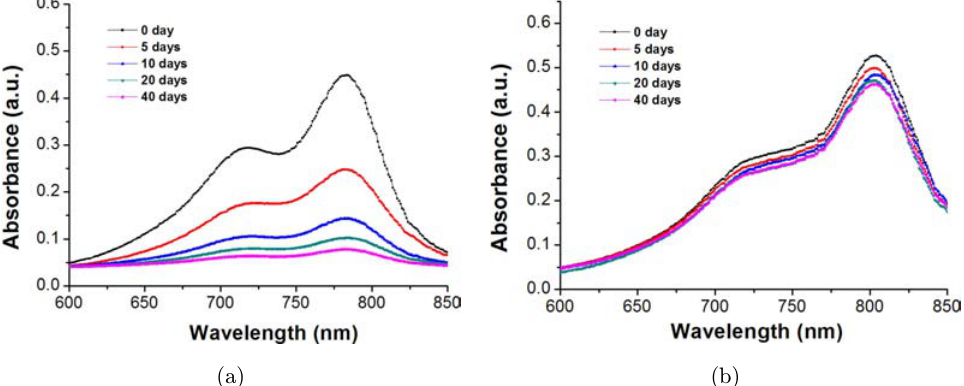
Fig. 3. Absorption of ICG (a) and ICG (cid:1) PL (cid:1) PEG nanoparticles (b) at di®erent times.